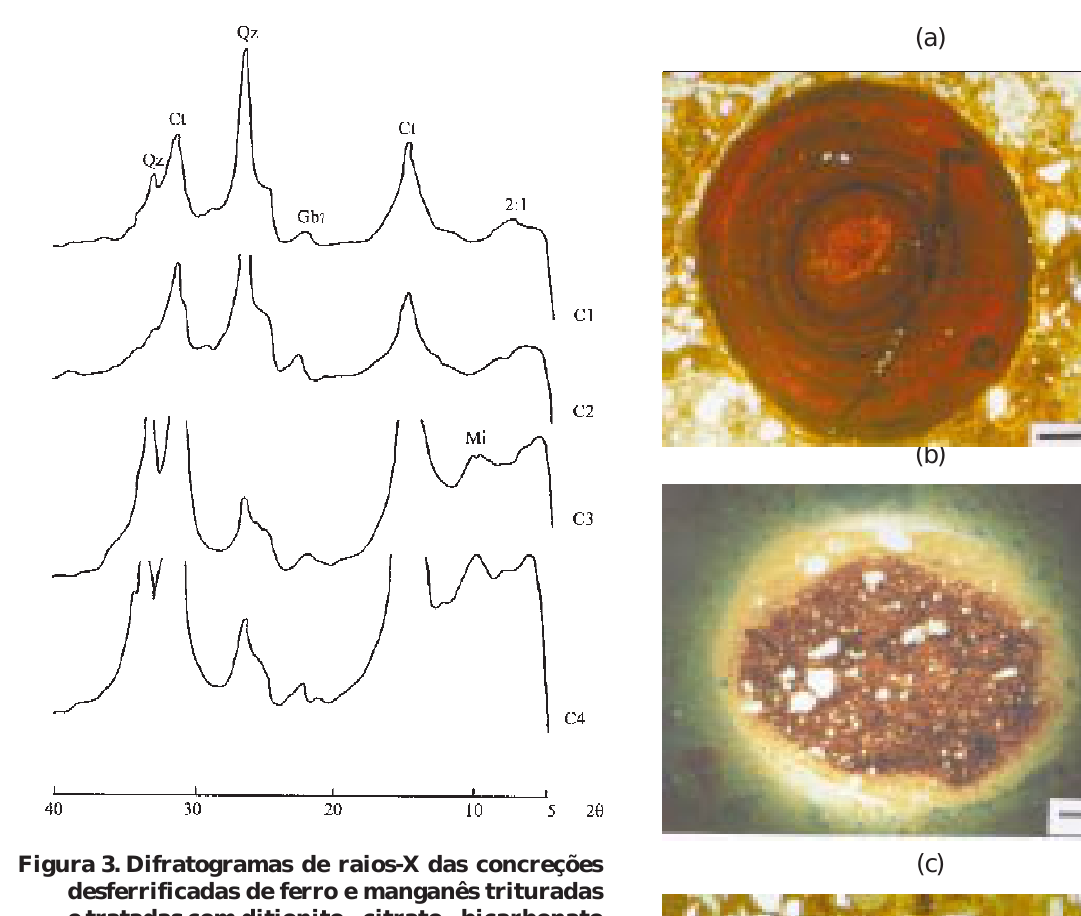
e no Vertissolo, estas concreções estão recapeadas por novos aportes de ferro, indicando que o processo está em